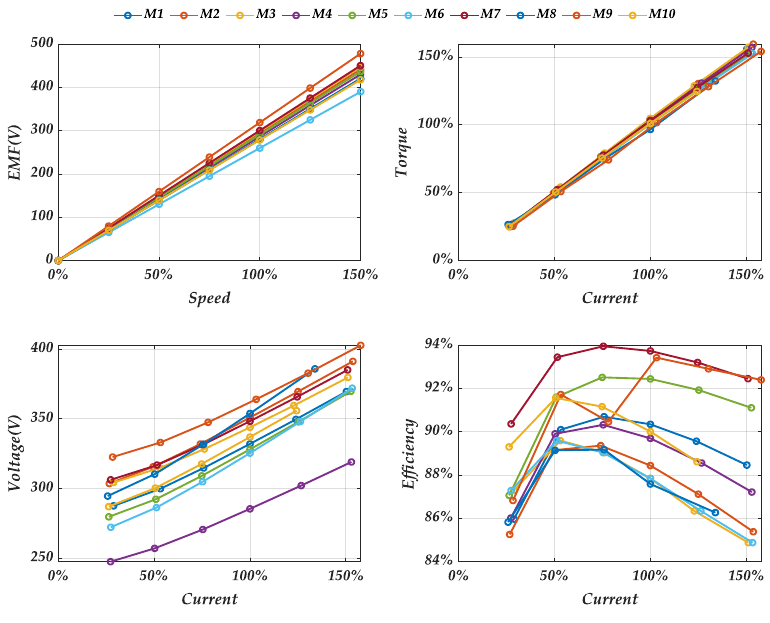
Figure 15. Experimental results of EMF, Torque, Voltage, and Efficiency vs. Current measured during the validation tests of the 10 sized motors.